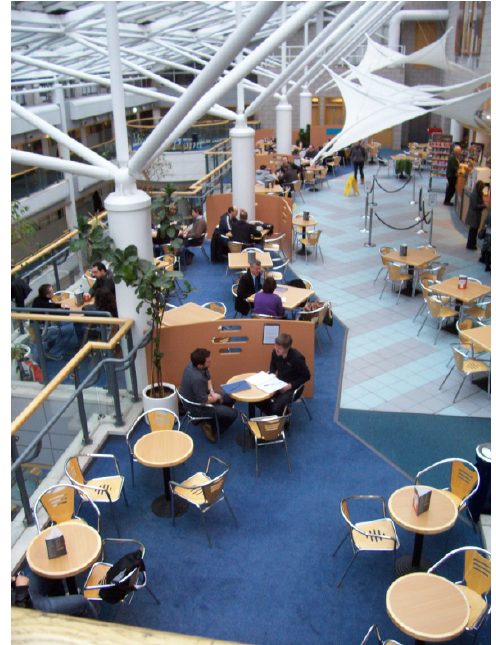
Figure 12. Northern Europe atrium—upper café